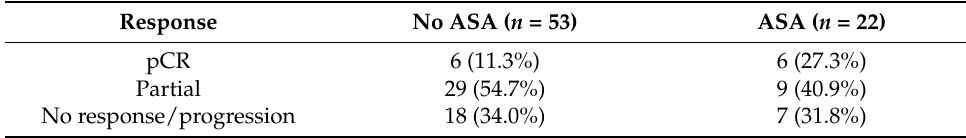
Table 2. Pathologic treatment response.